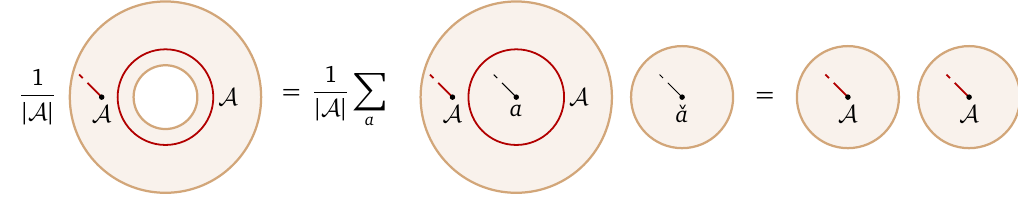
= T 2 × I (the transverse S 1 is kept implicit) in Figure 3: Surgery performed on Y 2 order to reduce it to S T 2 × S T 2 and show factorization of the partition function of theory T